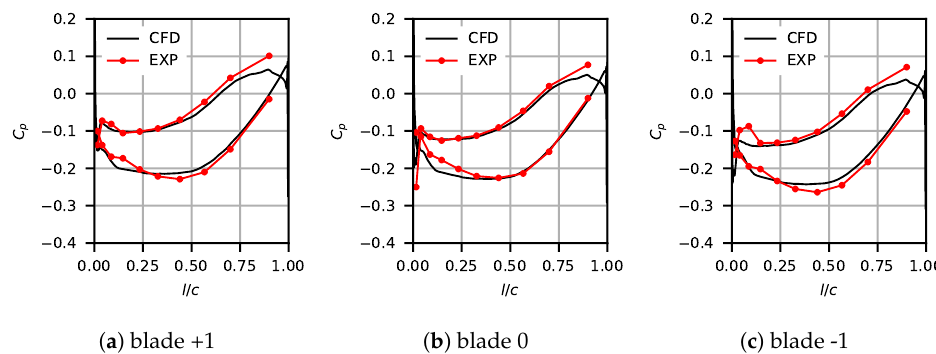
Figure 9. Validation of the steady mid-span surface pressure coefficient against normalised chord.